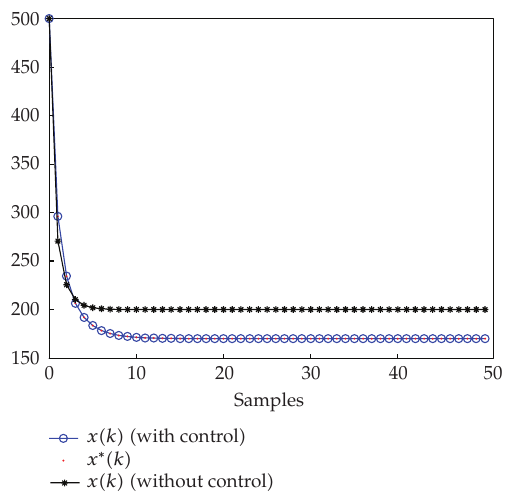
Figure 1: Evolution of the population of cod from x 0 (cid:7) 500.